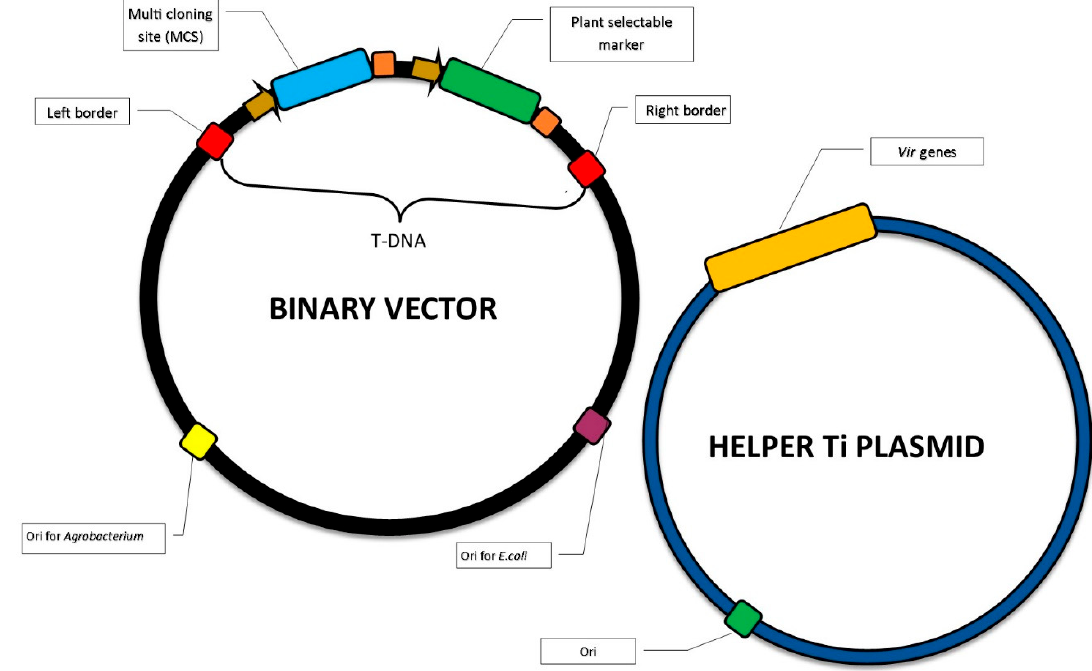
Figure 1. Schematic representation of binary and helper vectors used in plant genetic transformation.